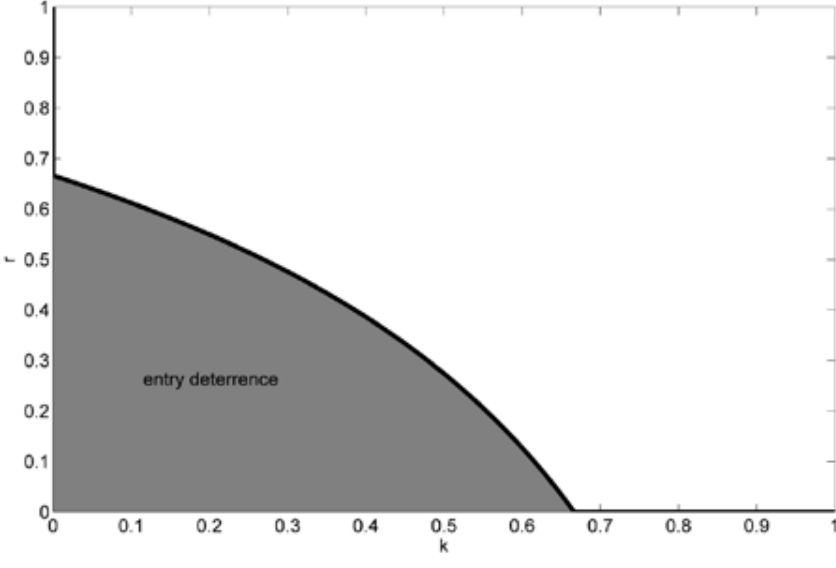
Figure 1. Effective entry deterrence depending on k and